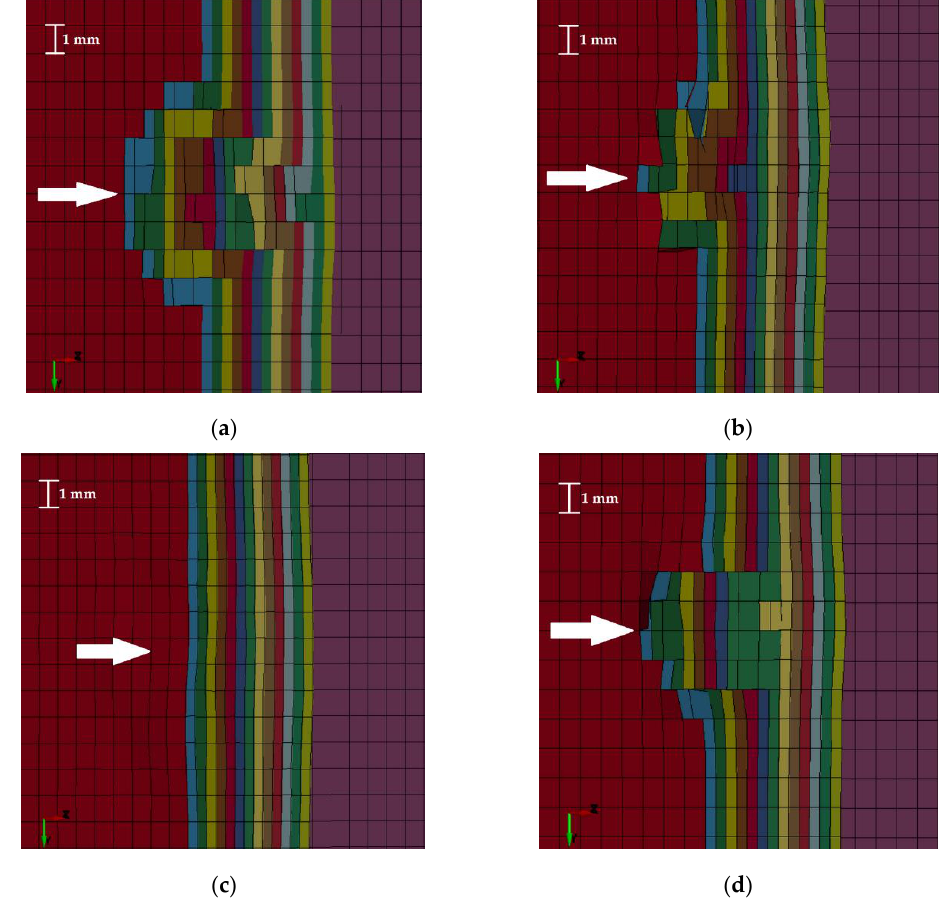
Figure 7. Cross sections of damaged areas caused by ( a ) conical striker, ( b ) hemispherical striker, ( c ) blunt striker, and ( d ) ogival